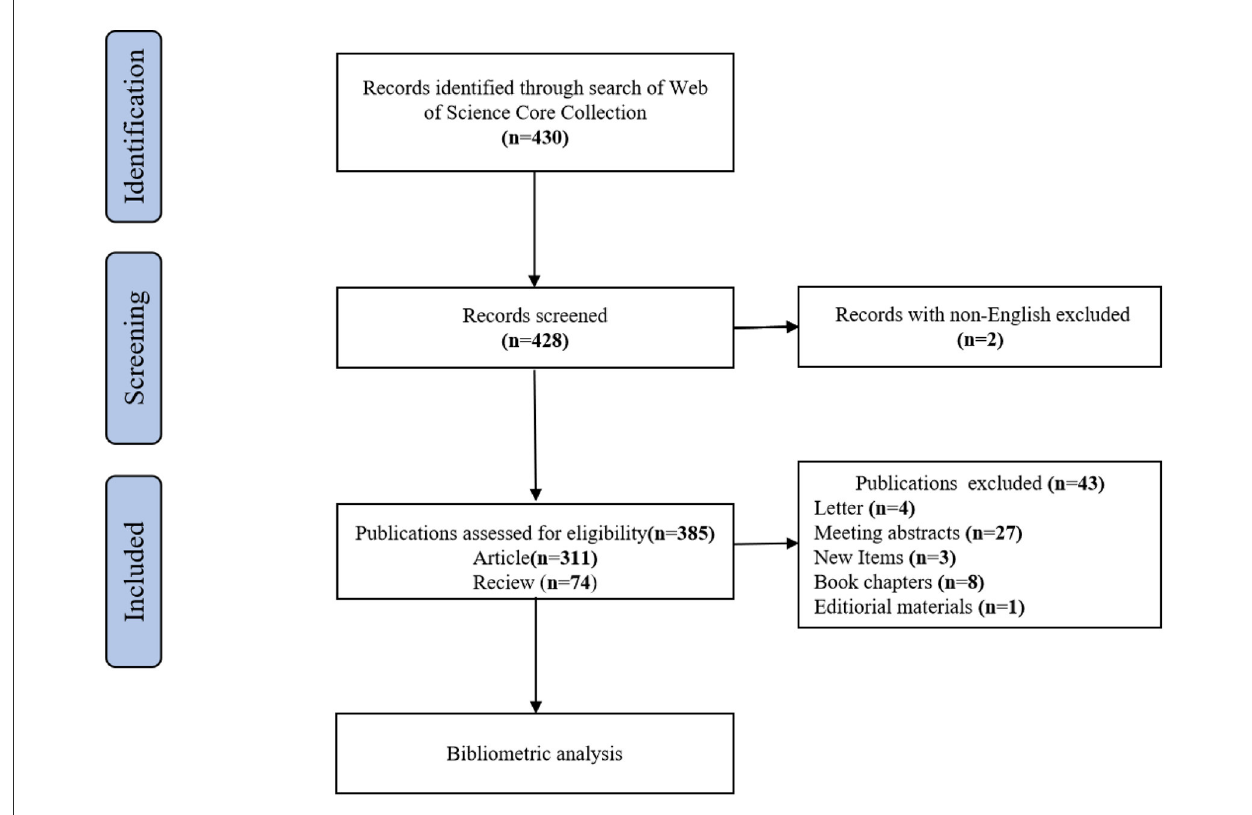
FIGURE1 The flowchart of publications